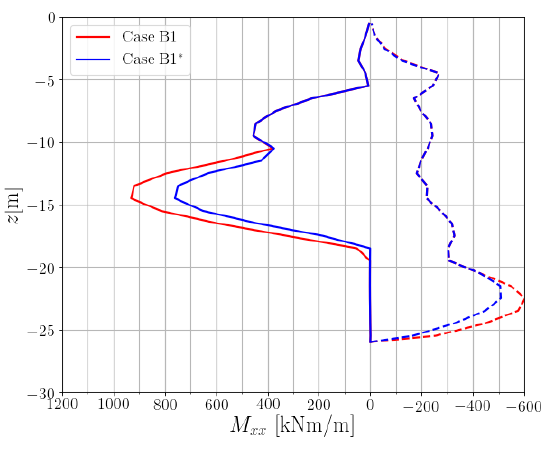
Figure 10: Comparison of characteristic bending moment envelopes based on all time instances registered until the last excavation step ∗ (B1 ) and then until the time instance at which the foundation raft is installed (B1).